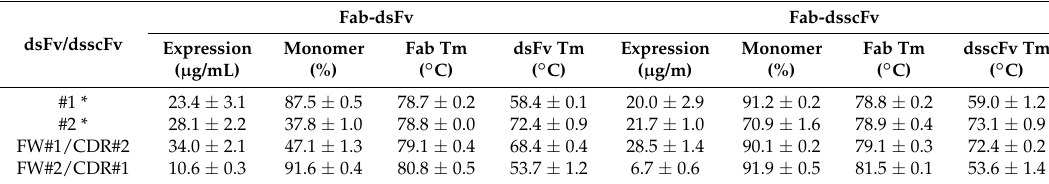
Table 3. Comparison of Fab-dsFv and Fab-dsscFv with wild type and FW/CDR-‘swapped’ Fv. ‘swapped’ Fab-dsFv and Fab-dsscFv proteins in the culture supernatant was measured by a Protein proteins analysed by G3000 SEC and differential scanning